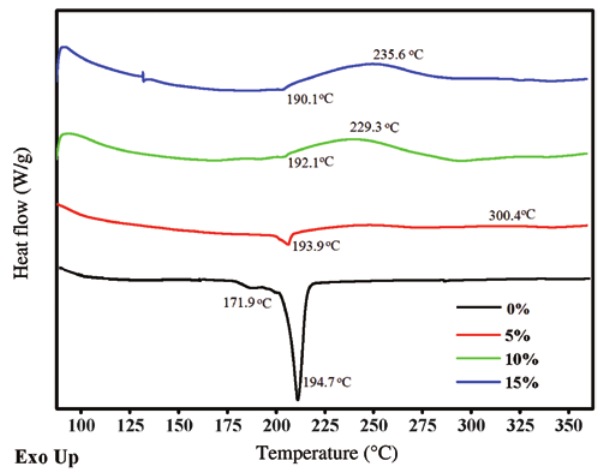
Figure 3: DSC curves of BAPh/PEN-OH prepolymers with various PEN-OH contents.